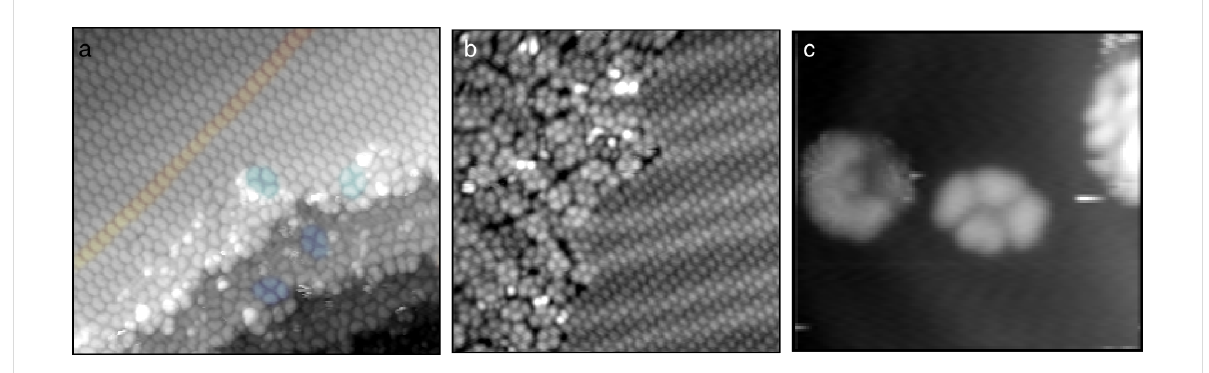
Figure 2: a) STM topography image, 250 Å × 250 Å, of 9,10-phenanthrenequinone on Au(111), with a representative row (red) and some representa- tive tetramers (blue) highlighted. b) STM topography image, 250 Å × 245 Å, of a boundary of tetramers and ordered rows on a single terrace. c) A 79 Å × 72 Å topography image (20 pA, +1.00 V) of an isolated tetramer in a low-coverage region of the surface.